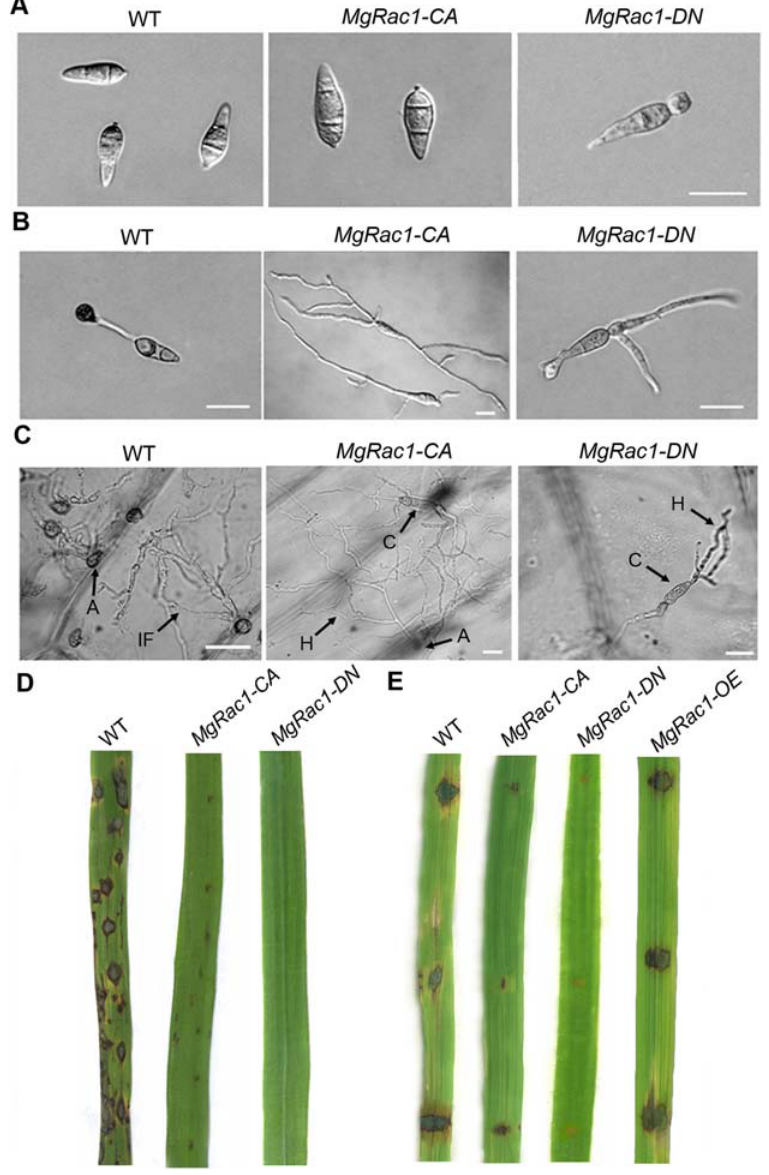
Figure 4. Abnormal conidial morphology, appressorial formation, and pathogenicity of the MgRac1 dominant mutants. (A) Differential interference contrast (DIC) microscopy of conidia collected from WT (70-15), MgRac1-CA (constitutively active mutant), and MgRac1-DN (dominant negative mutant), as indicated. Bar=20 m m. (B) Conidial suspensions of MgRac1-CA and MgRac1-DN were applied on the hydrophobic side of Gelbond film and examined with DIC microscopy. Bar=20 m m. (C) Conidial suspensions (about 1,000 conidia in 20 m l) of 70-15 and MgRac1 mutants were inoculated on strips of onion epidermis. Infectious hyphae were photographed 2 days after inoculation with DIC microscopy. A=appressorium, C=conidium, H=hypha, IF=infectious hypha. Bar=20 m m. (D) Leaves of rice cultivar CO39 were sprayed with conidial suspensions (1 6 10 5 conidia/ml) from WT, MgRac1-CA , and MgRac1-DN . Typical leaves were photographed at 7 days after inoculation. (E) Disease symptoms on the wounded leaf tissues of rice inoculated with conidia (5 6 10 4 conidia/ml) from WT and MgRac1 mutants, as indicated. And unwounded rice leaf tissue was inoculated with the mutant of MgRac1-OE . Typical leaves were photographed 5 days after inoculation.